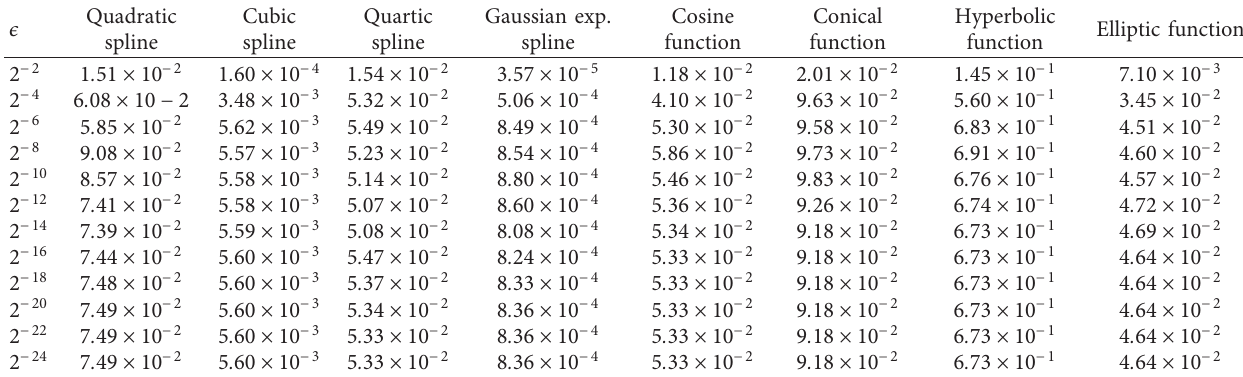
Table 1: Maximum absolute errors for Example 1 for different values of ϵ with linear basis functions.